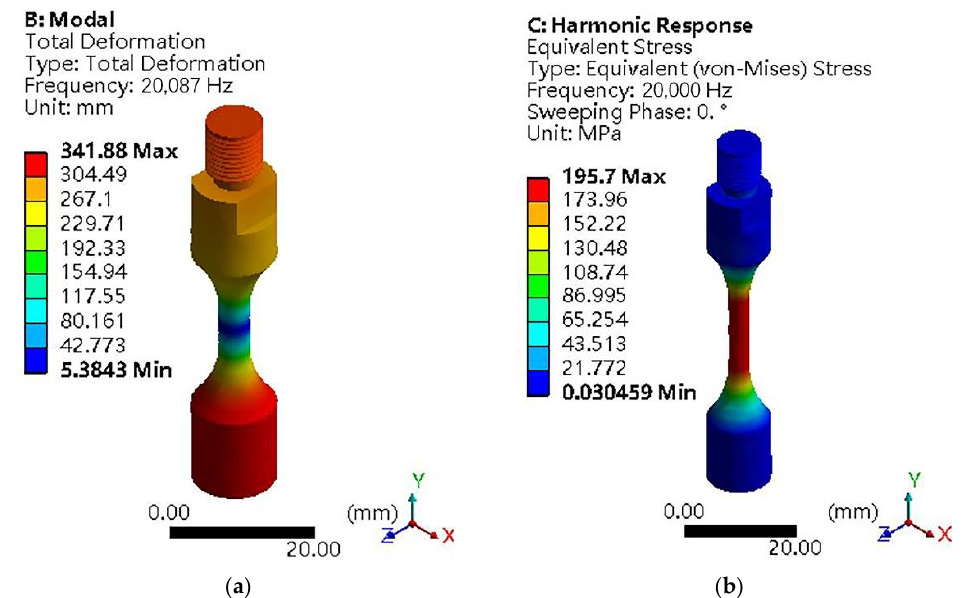
Figure 11. Finite element analysis results of the optimized sample: ( a ) Modal analysis; ( b ) harmonious response analysis.